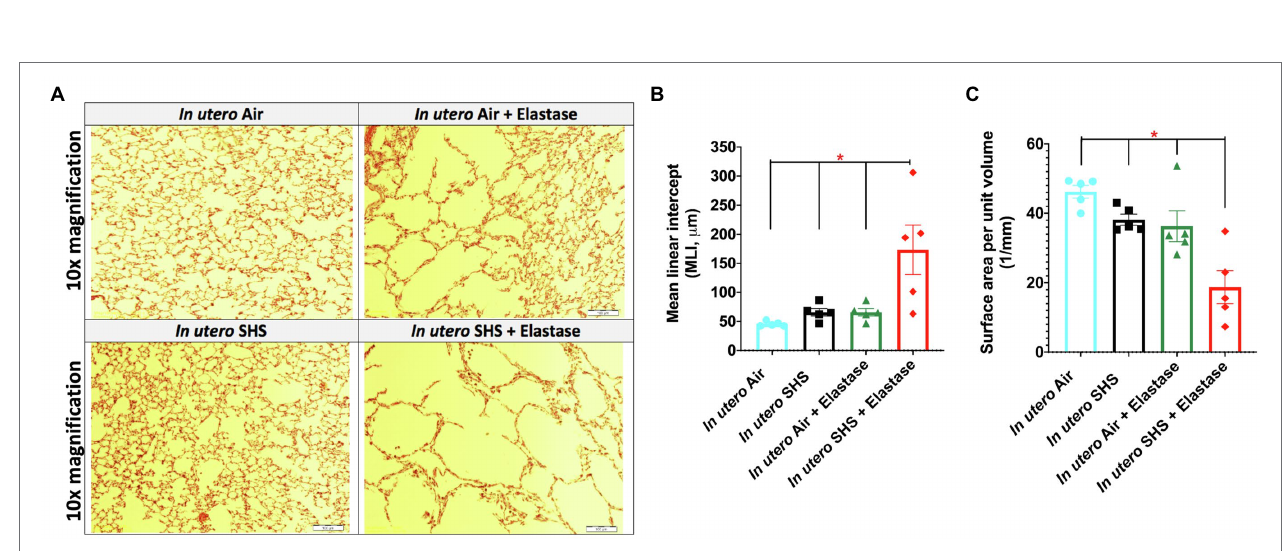
FIGURE 3 | In utero SHS plus adult elastase increased mean linear intercept and decreased lung surface area. (A) Representative images of H&E stained lung slides from 15-week-old female mouse offspring. (B) Quantification of lung tissue enlargement using mean linear intercept (MLI) and (C) surface area per